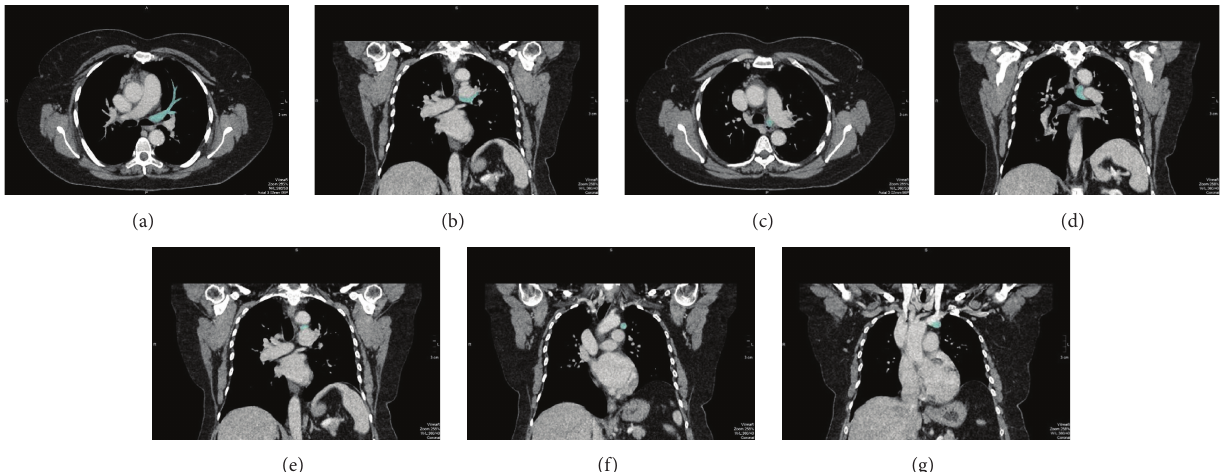
Figure 1: Axial and coronal sequential images: (a, b) the left upper pulmonary vein (light blue) first runs under the left pulmonary artery, (c, d) then goes up medially to it, (e, f) crosses the aortopulmonary window, and finally (g) joins the left brachiocephalic vein.